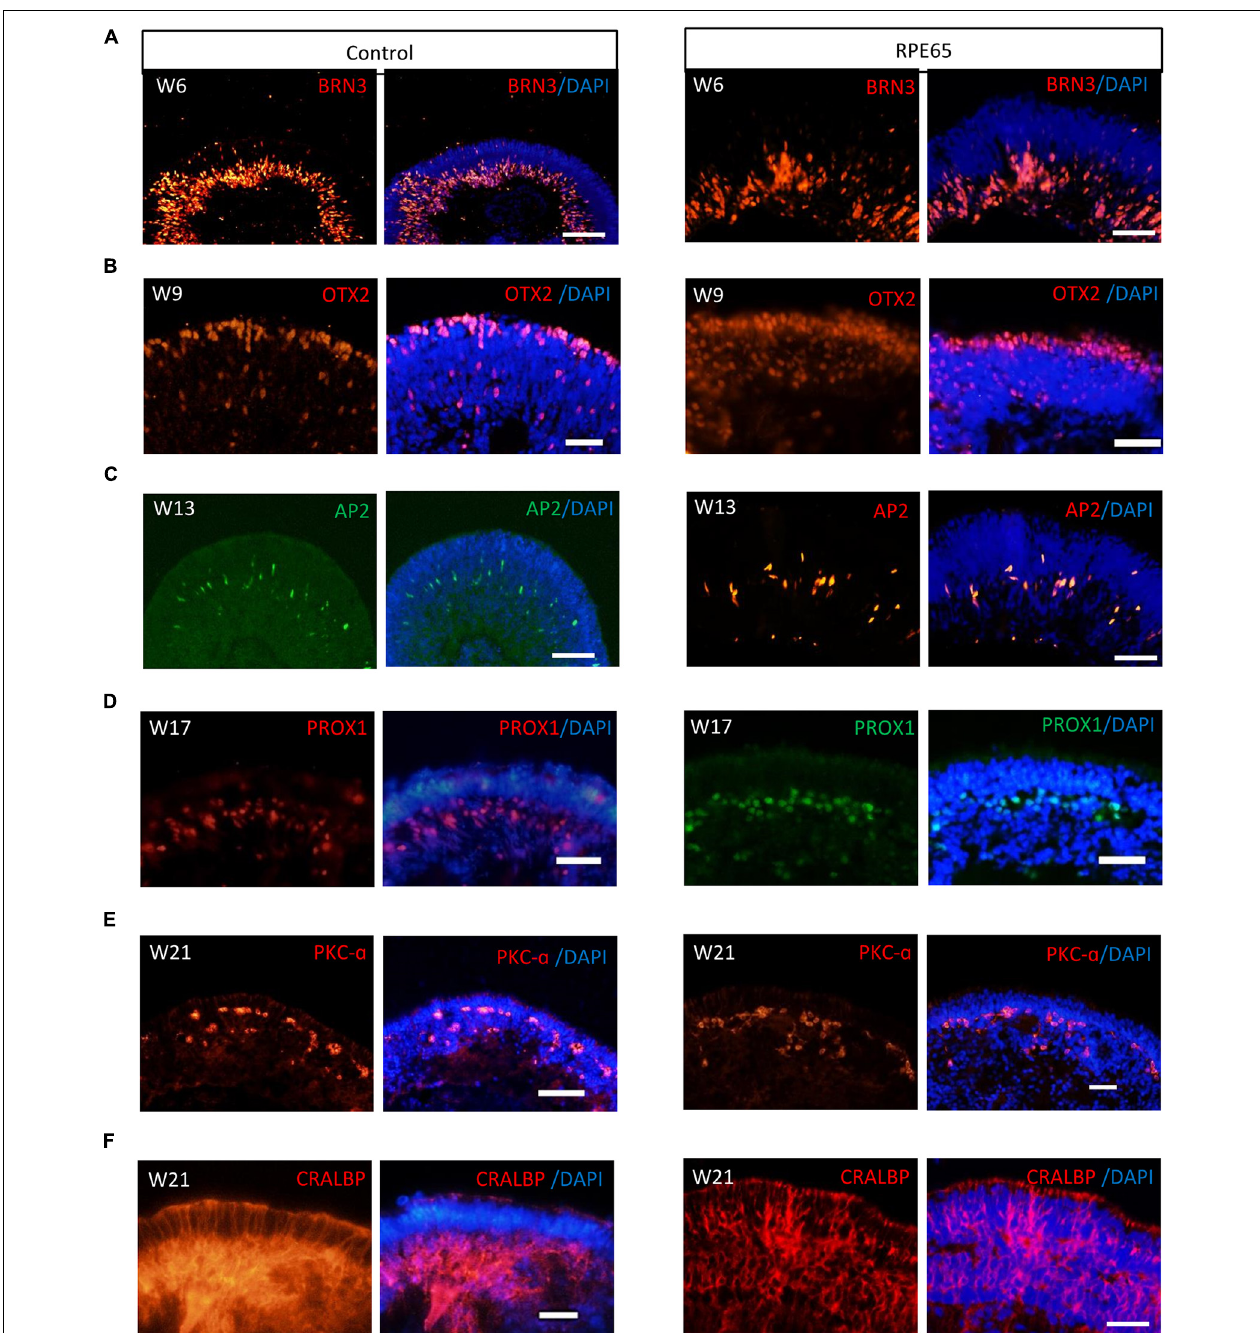
FIGURE 4 | RPE65-hiPSCs generated layered retinal organoids with all retinal cell types. Comparable to healthy control, neural retina in RPE65-hiPSCs derived retinal organoids developed laminated architecture with all major retinal cell types located in the corresponding layer. (A) BRN3 + retinal ganglion cells located in the basal side, (B) OTX2 + photoreceptor cells lying in the apical side, (C,D) AP2 + amacrine cells and PROX1 + horizontal cells lying in intermediate layer, (E) PKC-a + bipolar cells, and (F) CRALBP + Müller glial cells. Scale bars, 20 µ